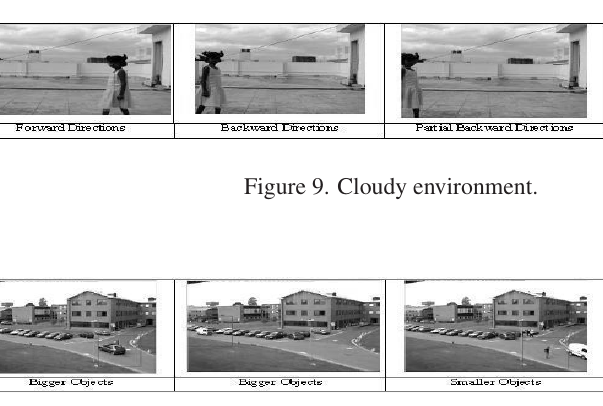
Figure 10. Noisy and complex background.